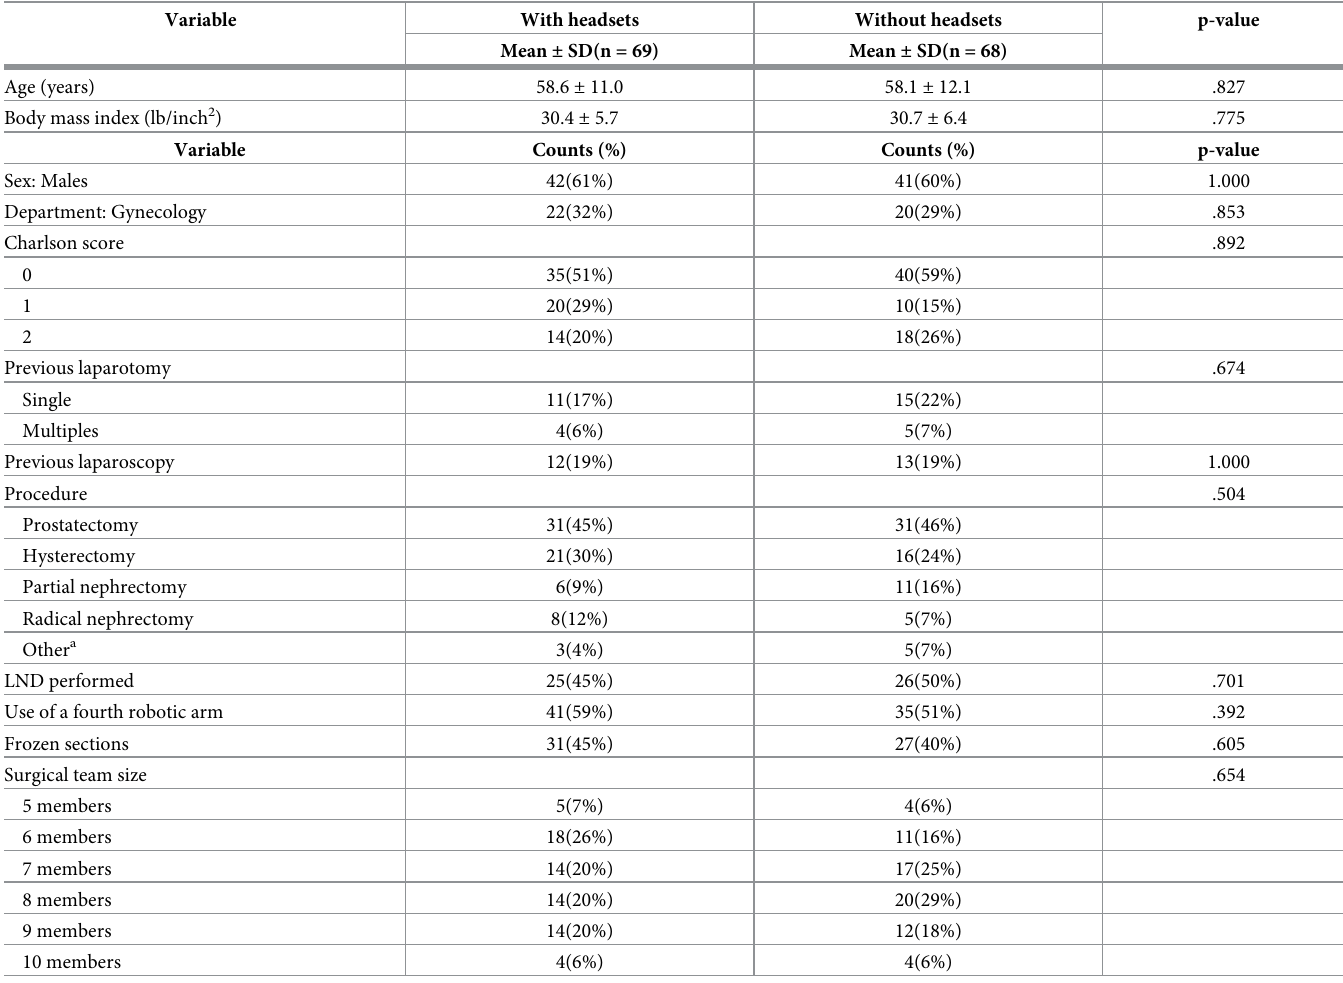
Table 1. Descriptive statistics of patients and